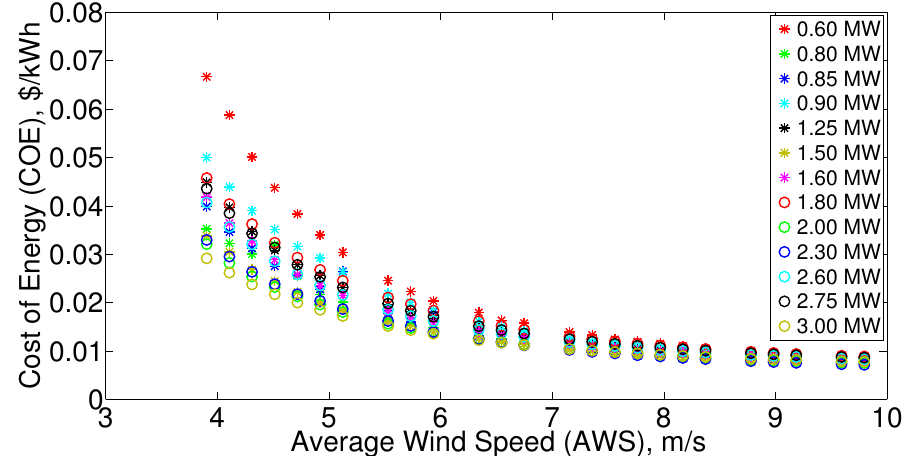
Figure 6. The minimized COE given by the best performing turbines (of each rated-power class) for each sample